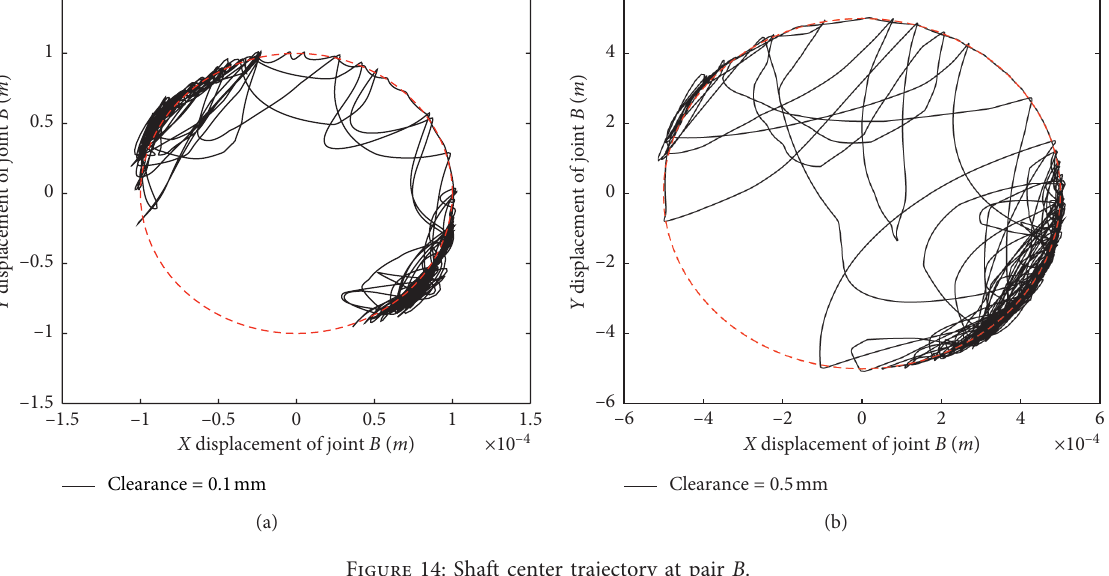
Figure 14: Shaft center trajectory at pair B .